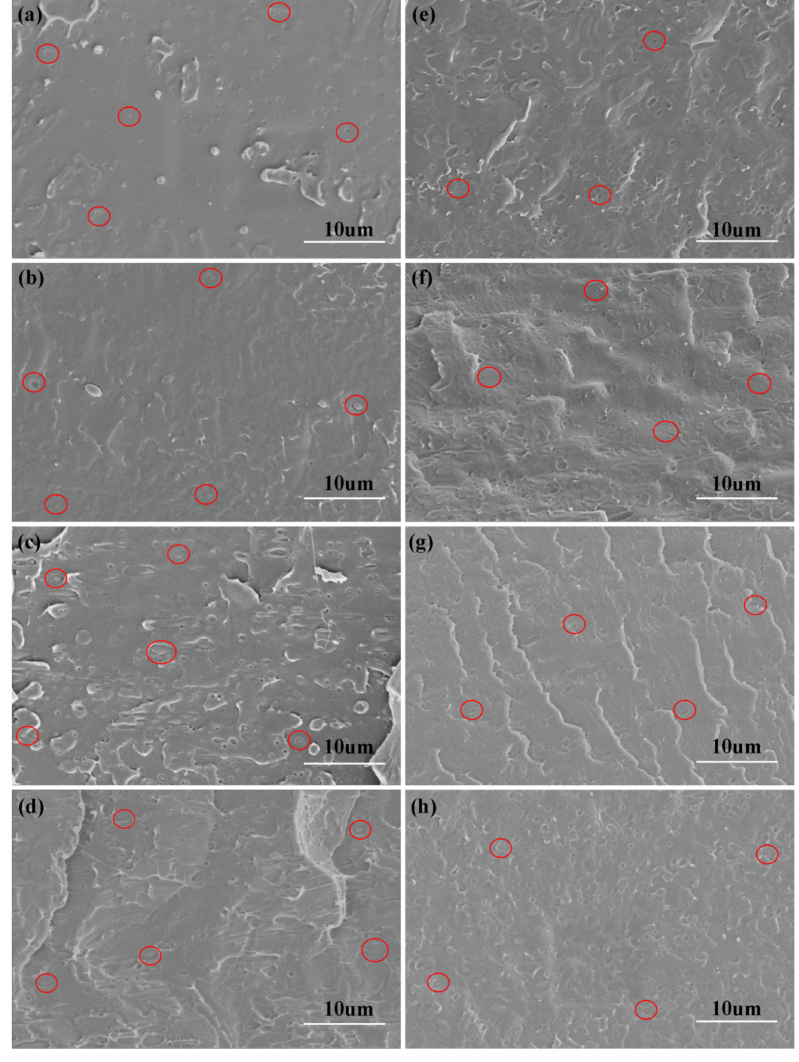
Figure 5. FESEM graphs of the fractured surface of ( a ) PT1, ( b ) PT3, ( c ) PT5, ( d ) PT10, ( e ) PT10/PTC2.5, ( f ) PT10/PTC5, ( g ) PT10/PTC7.5, and ( h )